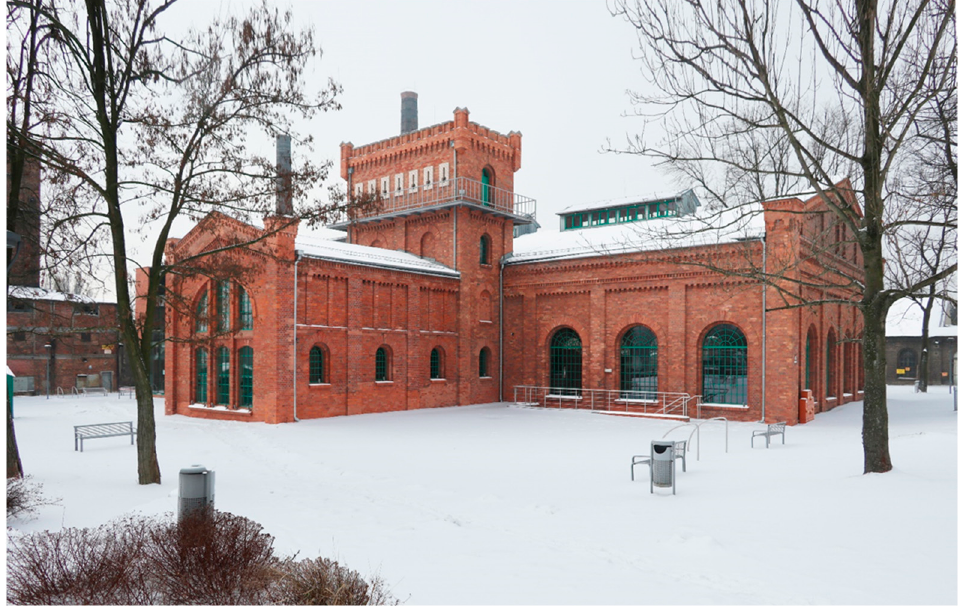
Figure 3. “Elektrownia” (Power Plant) Contemporary Art Gallery in Czelad´z, photo by Michał Pieczka.